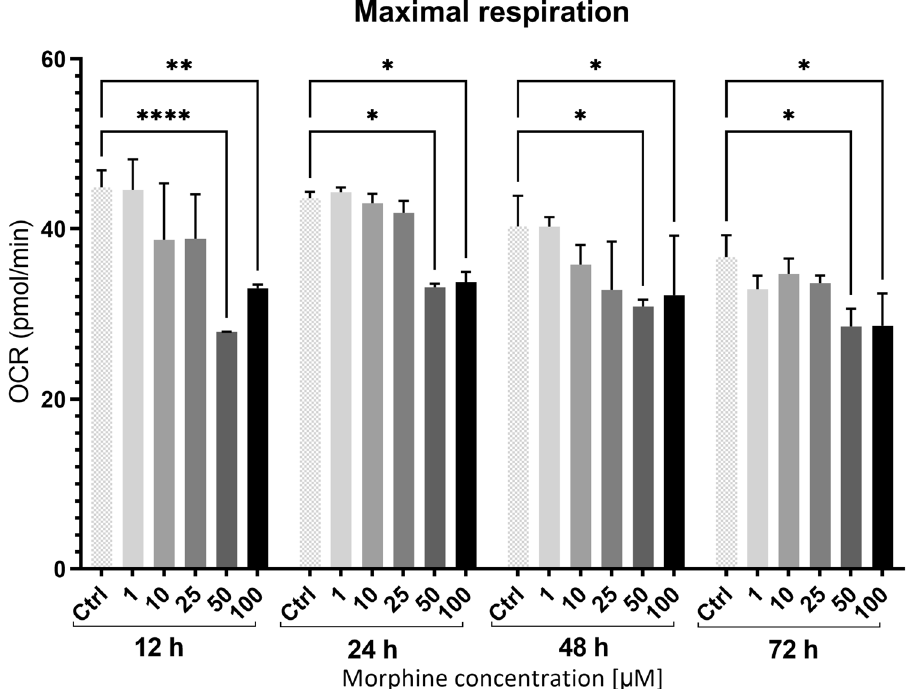
Figure 4. Mitochondrial function measurements from Seahorse Assay. Maximal respiration is represented for each time point and morphine concentrations. OCR correspond to Oxygen Consumption Rate and data were normalized. Data are represented as means ± SD of four biological replicates. Statistical significance of each measure from treated cells toward the control culture was evaluated with a two-way ANOVA test. Significant p -values: * p -value < 0.05, ** p -value < 0.01 and **** p -value < 0.0001. Ctrl =